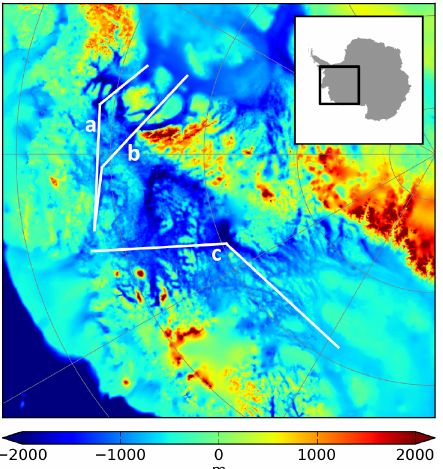
Figure 1. Topographic map of the bedrock underlying the Antarctic Ice Sheet. Each of the transects (white lines) connects two major drainage basins of the WAIS. The bed topography and the ice pro- file along transects (a) , (b) and (c) are shown in the corresponding panels of Fig. 2.